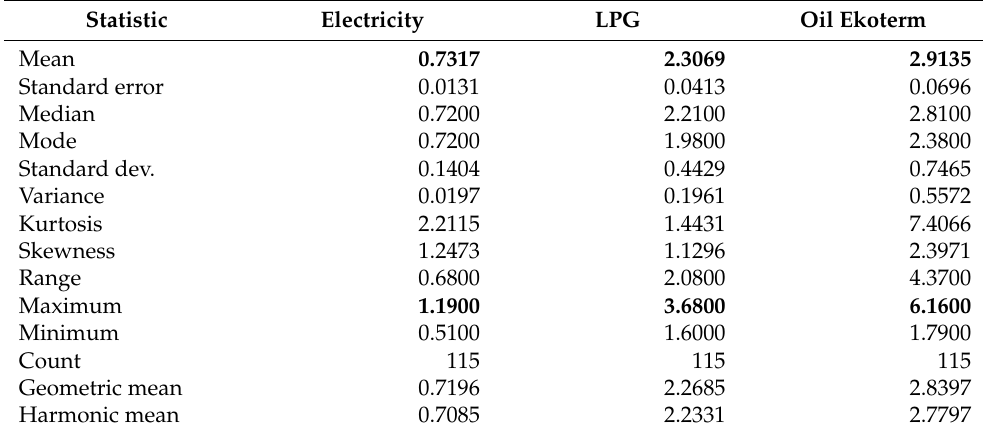
Table 3. Descriptive statistics of prices of three heating energy sources, January 2013–July